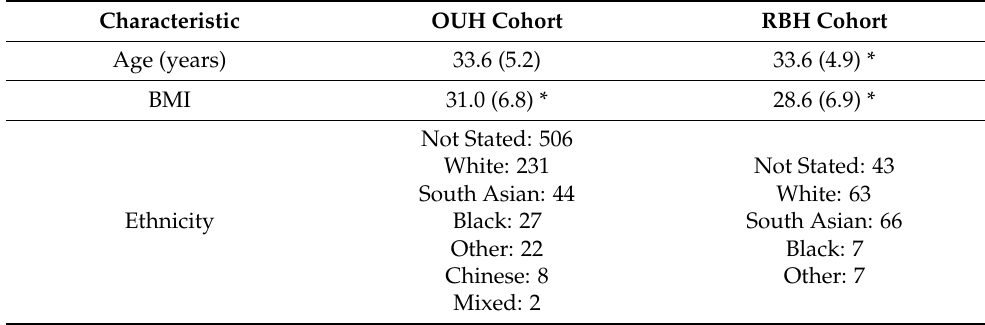
Table 2. Patient characteristics and statistics for OUH and RBH cohorts. Mean values are recorded alongside standard deviation (where applicable). * missing values